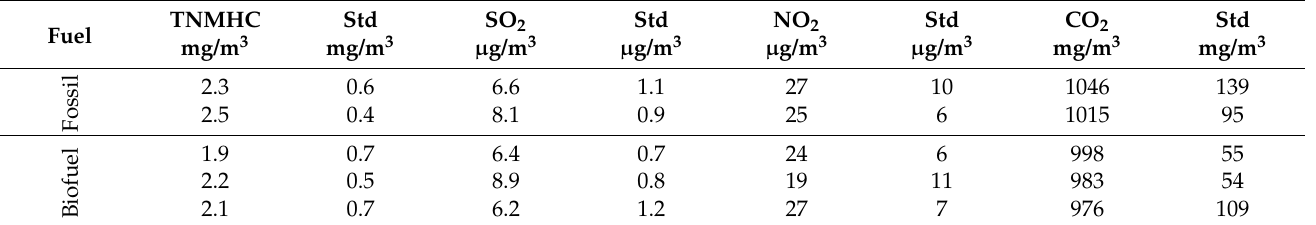
Table A3. Volatile compounds’ emission indexes (in unit mass per cubic meter) measured during background monitoring.